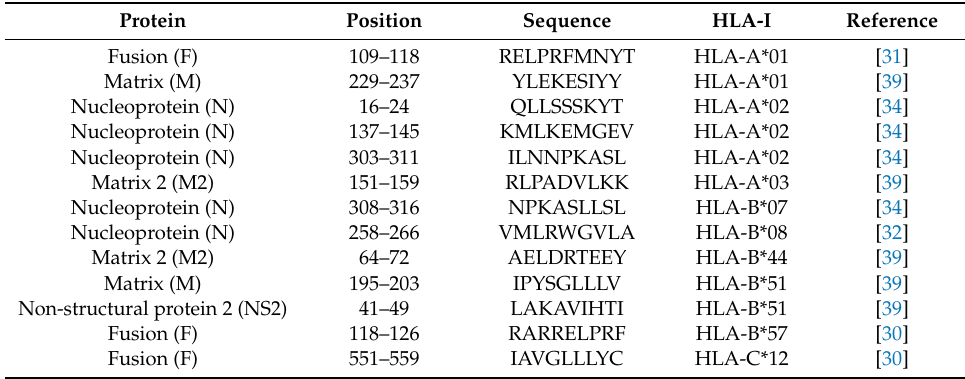
Table 1. Summary of human leukocyte antigen (HLA) class I epitopes of human respiratory